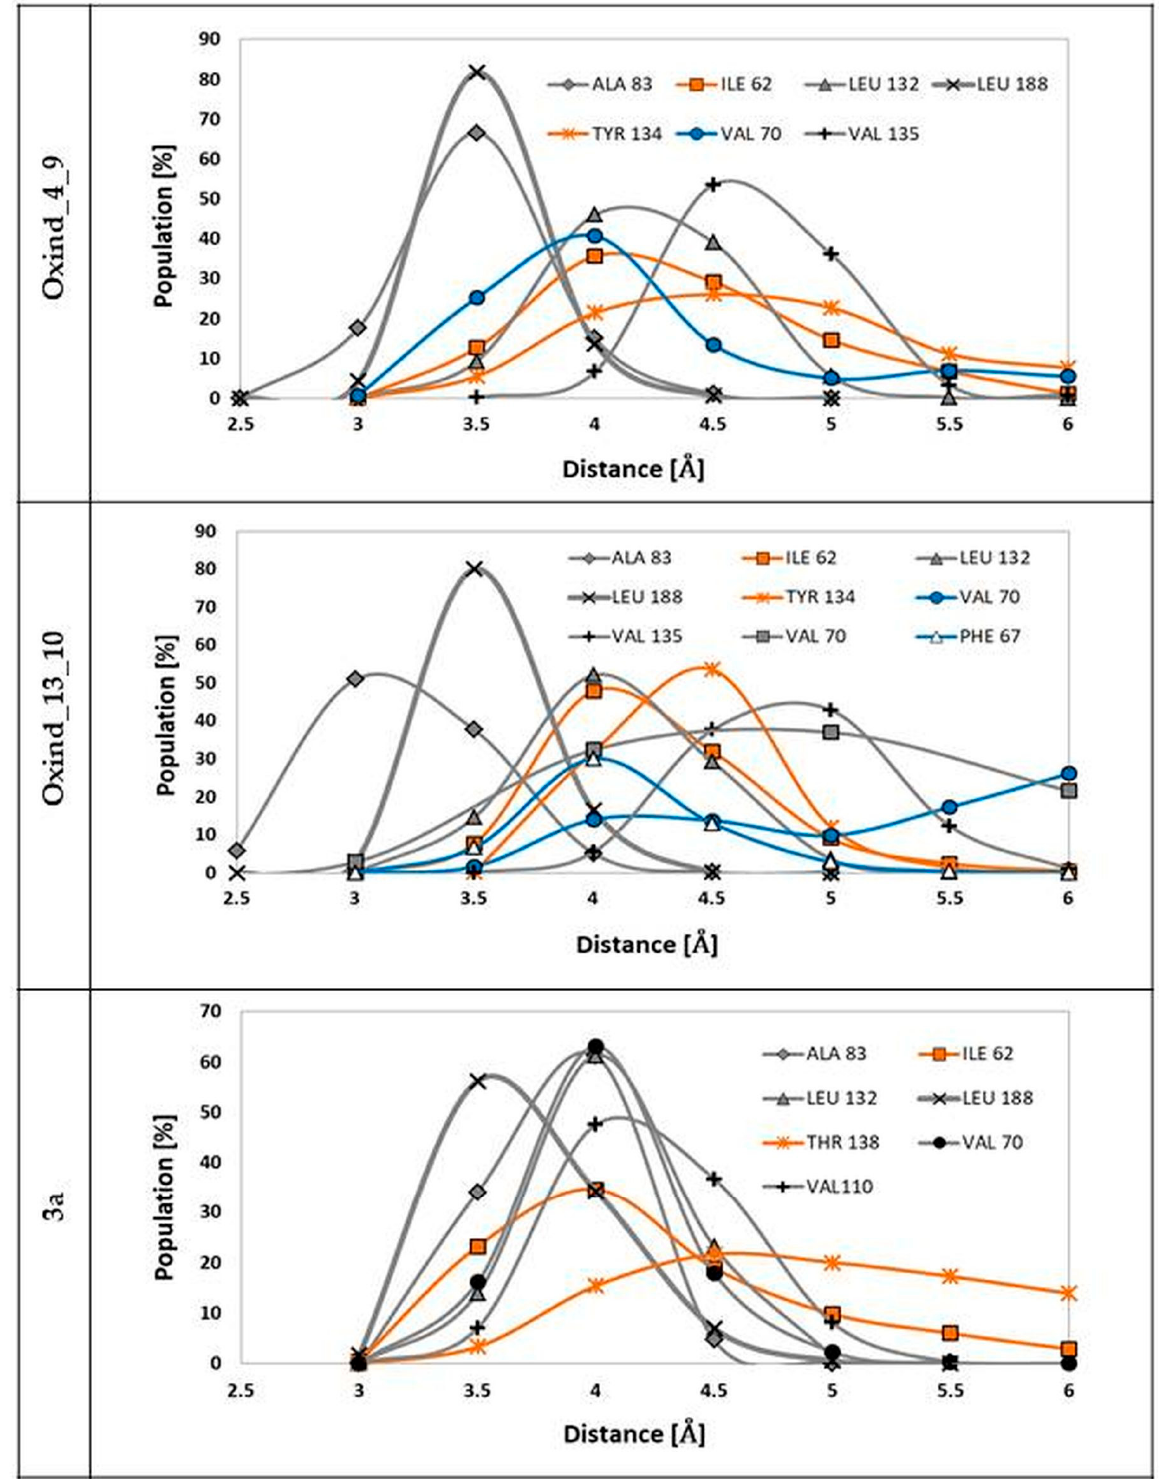
Figure 5. The distributions of distances measured between hydrophobic moieties of particular residues from GSK-3 β active site and carbon atoms from ligand molecules. The grey distributions represent residues interacting with the molecular core, the blue distributions represent residues interacting with functional groups localized in the R1 position and the orange distributions represent residues interacting with functional groups connected to the R2 position. The markings on the left side of individual figures are the names of ligands involved in interactions presented on particular charts.